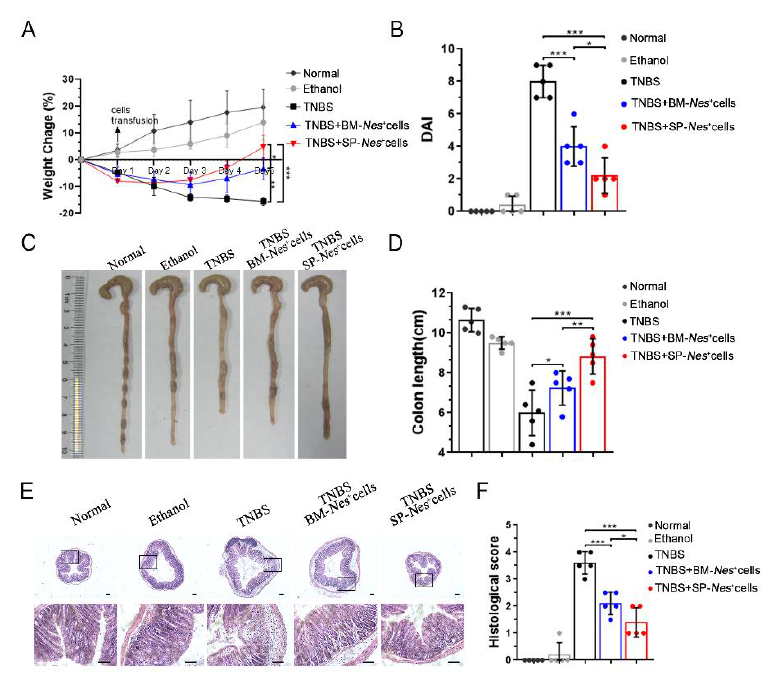
Figure 6. Spleen-derived Nes -GFP + cells as a potential source for the treatment of inflammatory diseases: ( A ) Therapeutic efficacy evaluation of TNBS-induced IBD model, bodyweight change percentage of each group. n = 3; ( B ) Disease activity index (DAI) were measured. n = 5; ( C ) Representative colonic length of mice; ( D ) Quantification of the colonic length of mice. n = 5; ( E , F ) H&E staining and corresponding histological scoring of each group. n = 5. Scale bars, 100 μm. * p < 0.05, ** p < 0.01, *** p < 0.001.